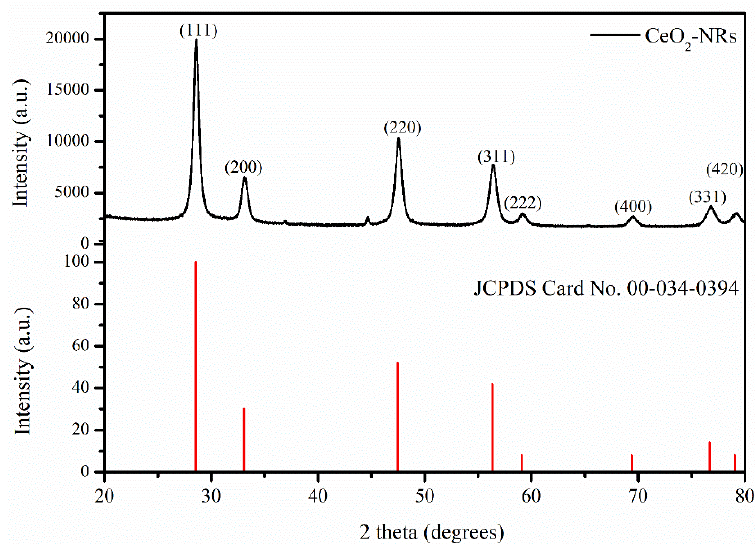
Figure 2. XRD spectrum of CeO 2 -NRs and the standard JCPDS Card no. 00-034-0394.